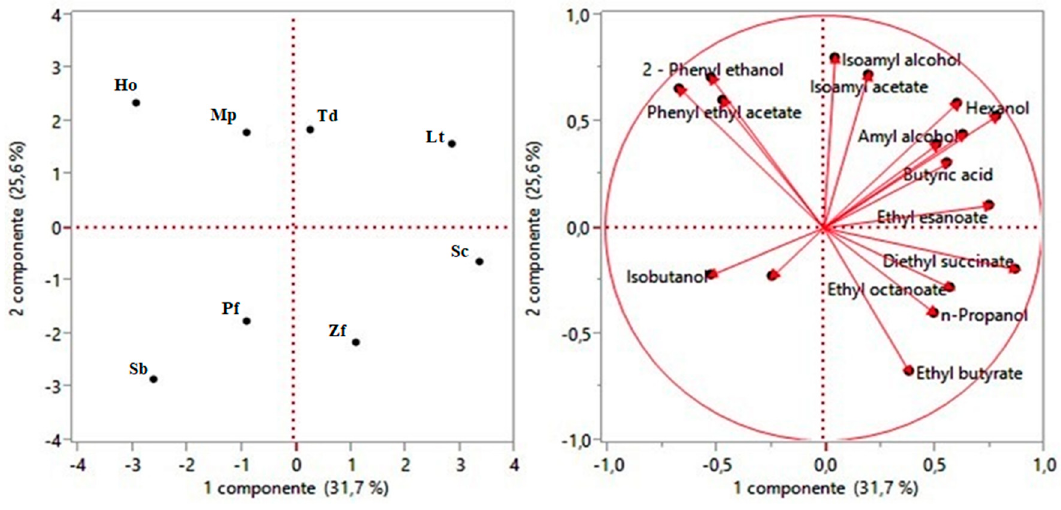
Figure 4. Principal component analysis (PCA) based on the production of volatile compounds.